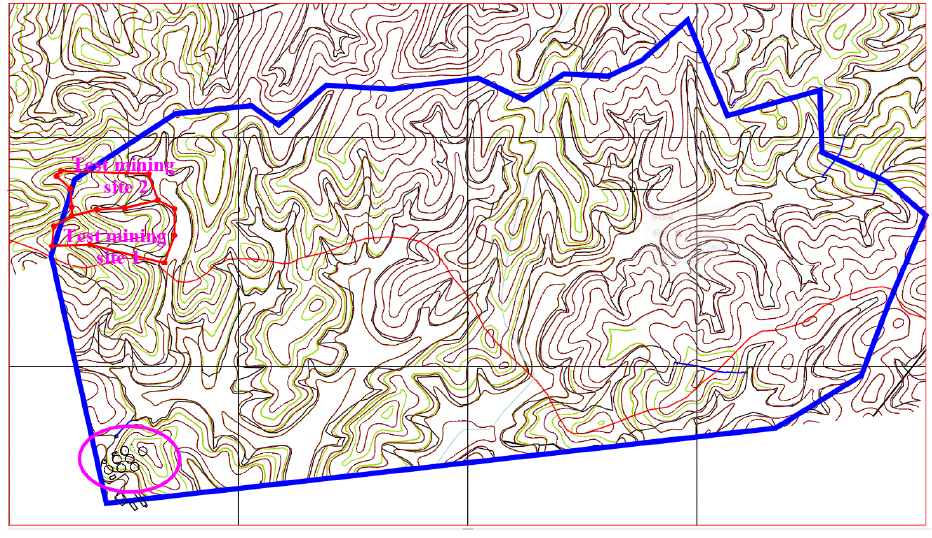
Figure 4. Geological and topographic map of the mining area.